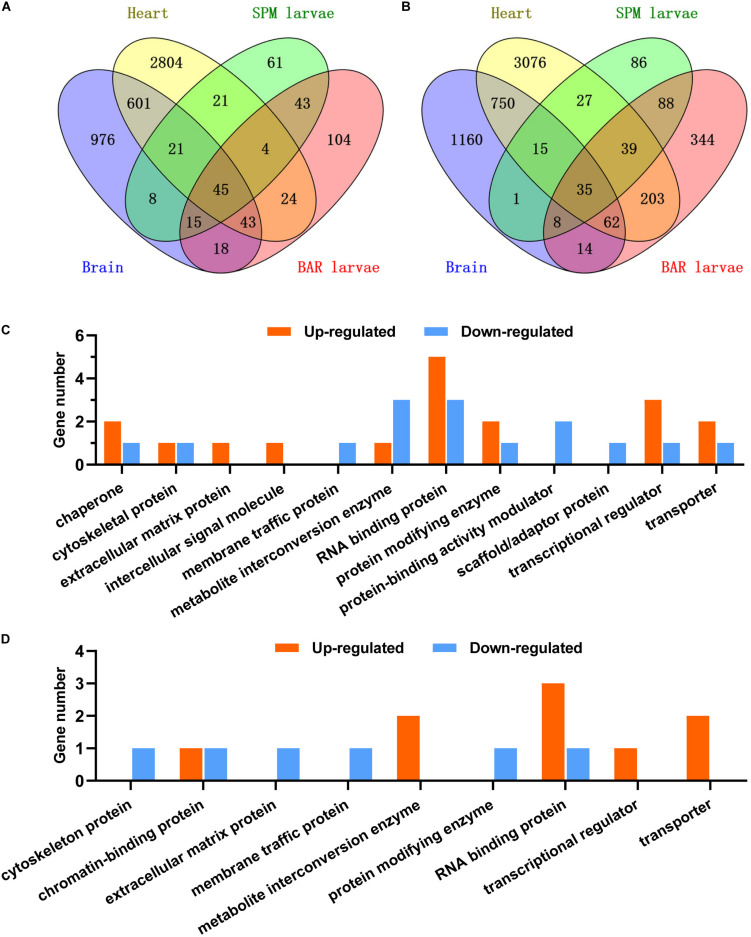
The core cold responsive genes of common carp. (A,B) Venn charts indicate the core set of genes up-regulated (A) or down-regulated (B) in all the experiments. Data of the brains and hearts were generated in this work, data of the SPM and BAR (Barbless carp) larvae were from our previous study (Ge et al., 2020). (C,D) Classification of the up-regulated (C) and down-regulated (D) core (differentially expressed in all the 4 cases) and common (differentially expressed in the cases except for BAR) genes according to the PANTHER protein class annotations (Mi et al., 2019).